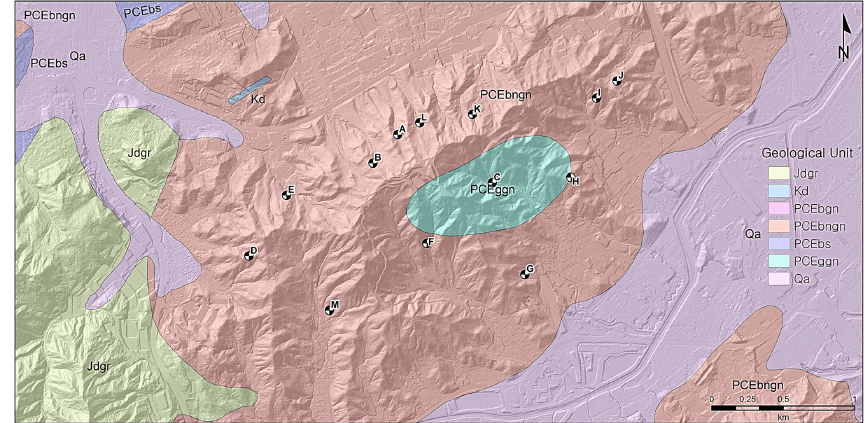
Figure 3. Geological map of the study area. Major landslide areas described in Fig. 2 are also shown. Representative geological units are: Jdgr (Jurassic Daebo granite), Kd (dikes), PCEbngn (pre-Cambrian era banded biotite gneiss), PCEbs (pre-Cambrian era biotite schist), PCEggn (pre-Cambrian era granitic gneiss), and Qa (Quaternary alluvium). All geological information are based on Kim and Hong (Kim and Hong, 1975) and Hong and Lee (Hong and Lee,